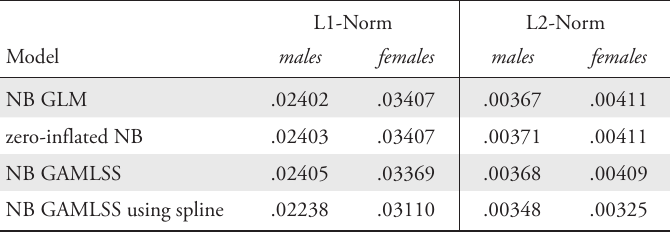
Table 6: L1 and L2-Norm prediction errors of case